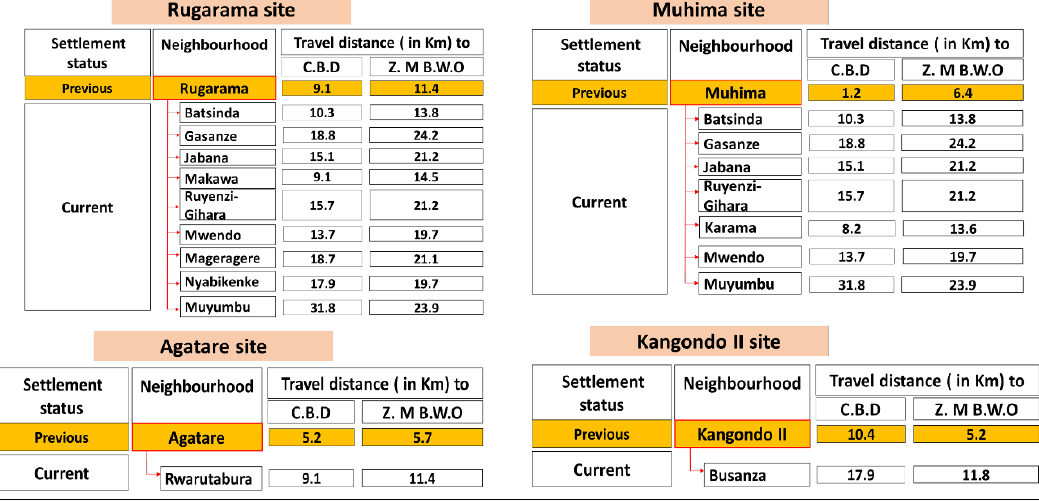
Figure 10. Travel to working places before and after expropriation. Data source: Kigali city, Geo-datasets on socio-economic facilities in Kigali city and neighbouring districts. Household surveys and field observations.